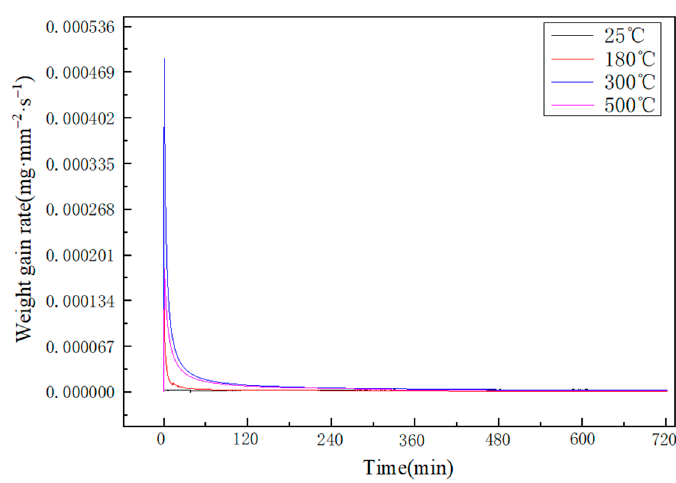
Figure 9. Oxidation rates of Al–Sn alloys at different temperatures.